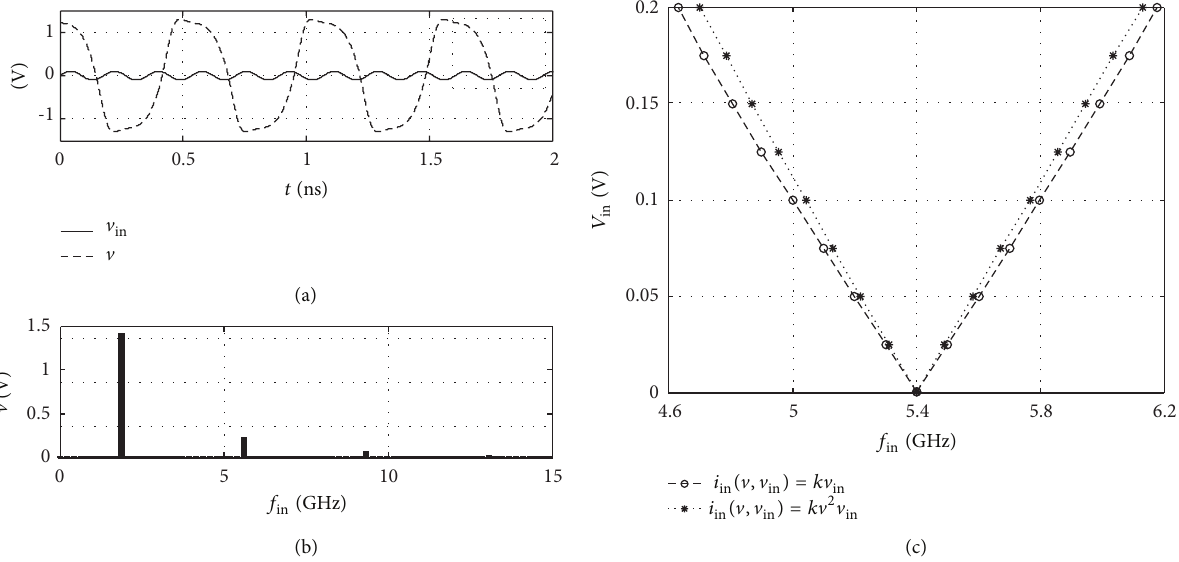
( V ) = 𝑎 V + 𝑎 V 3 , 𝑖 ( V , V ) = 𝑘 V , 𝑎 1 = −12 mA/V, 𝑎 3 = 8 mA/V 2 , 𝑘 = 1 3 nl in in in = 0.1 V, 𝑓 = 5.6 GHz. (a) Time waveforms of the input and output signals. (b) in in